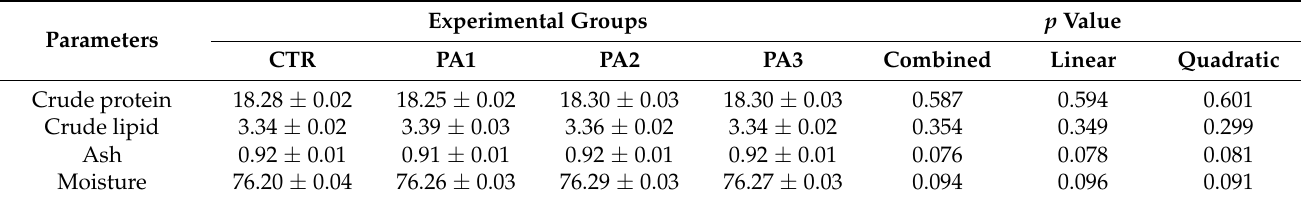
Table 5. The effects of P. australis extract (0, 100, 200, and 400 mg extract/kg diet) dietary administra- tion on fillet composition (% wet weight basis) of common carp for 56-days ( n =